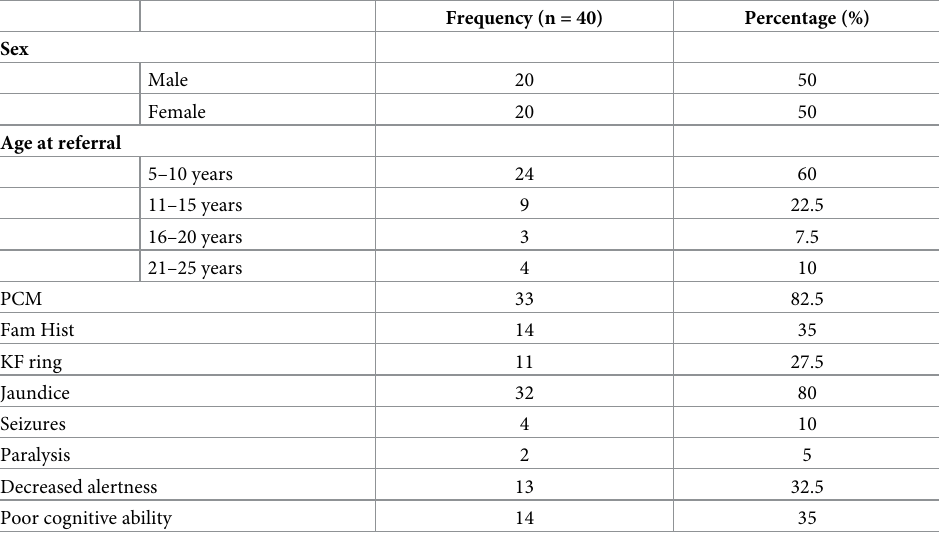
Table 1. Demographic information of children with Wilson’s disease in